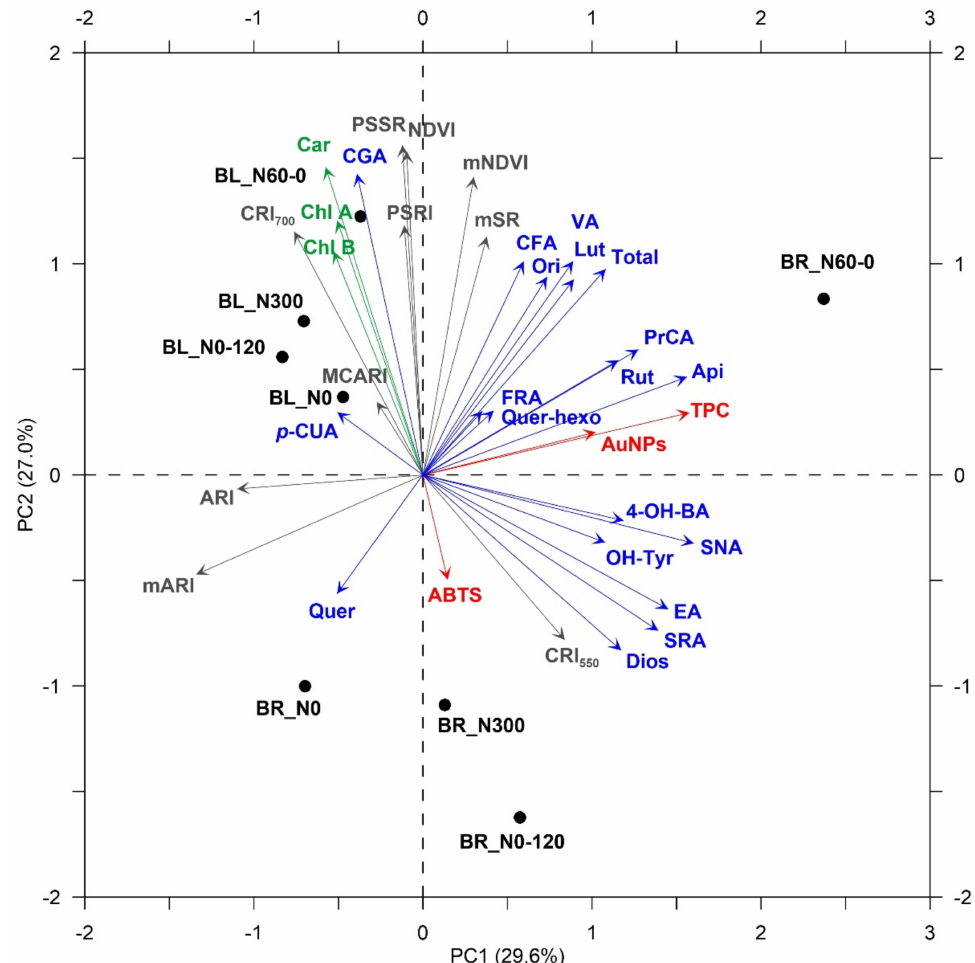
Figure 4. Two-dimensional correlation bi-plot from principal component analysis (PCA) performed on data observed in wheatgrass obtained from two Triticum aestivum cultivars (Bologna, BL; Bora, BR) subjected to four different N fertilization schedules (N0: unfertilized control; N300: constantly well N fertilized throughout the growth cycle; N60-0: N fertilized only one month after sowing; N0-120: N fertilized only late at initial shoot elongation). Symbols show the standardised scores on PC1 (x-axis) and PC2 (y-axis) for the eight treatments (BL_N0; BL_N300; BL_N60-0; BL_N0-120; BR_N0; BR_N300; BR_N60-0; BR_N0-120); vectors’ coordinates represent the correlations between standardised variables (green group: pigments; red group: results from photometric analysis; blue group: phenolic profile from LC-MS/MS; grey group: reflectance-derivate vegetation indices—see text for labels) and